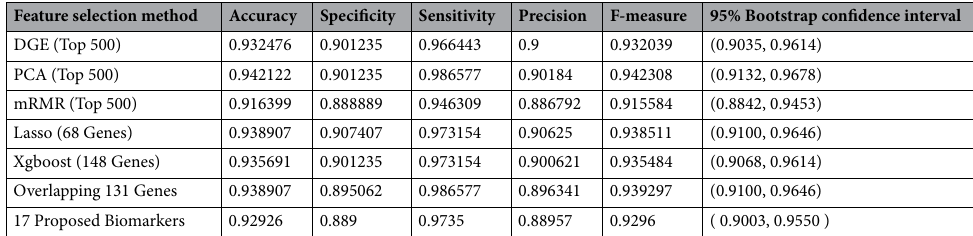
Table 3. LUAD and LUSC Classification Statistics.